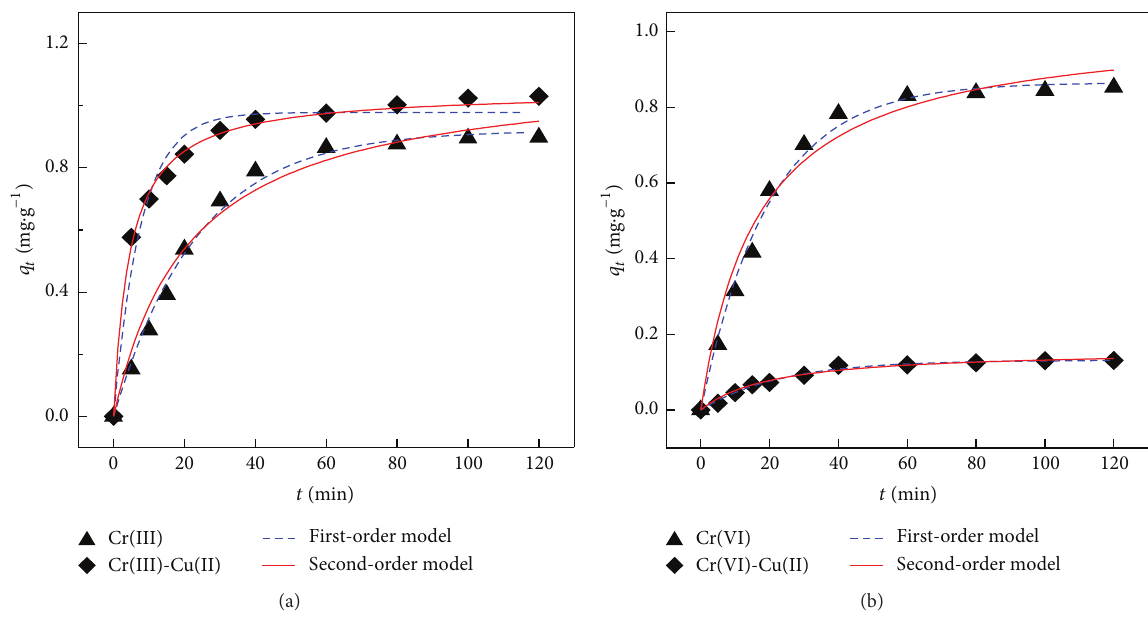
Figure 1: The Cr(III) (a) or Cr(VI) (b) adsorption kinetics onto kaolin in the absence and presence of Cu(II). The 󳵳 and X are the measured data. The dashed and solid curves are fittings using pseudofirst-order and second-order models, respectively (adsorption conditions: 𝑐 0 for Cr(III) = 300 mg ⋅ L −1 , for Cr(VI) and Cu(II) = 200 mg ⋅ L −1 , pH = 4.5, and temperature = 25 ∘